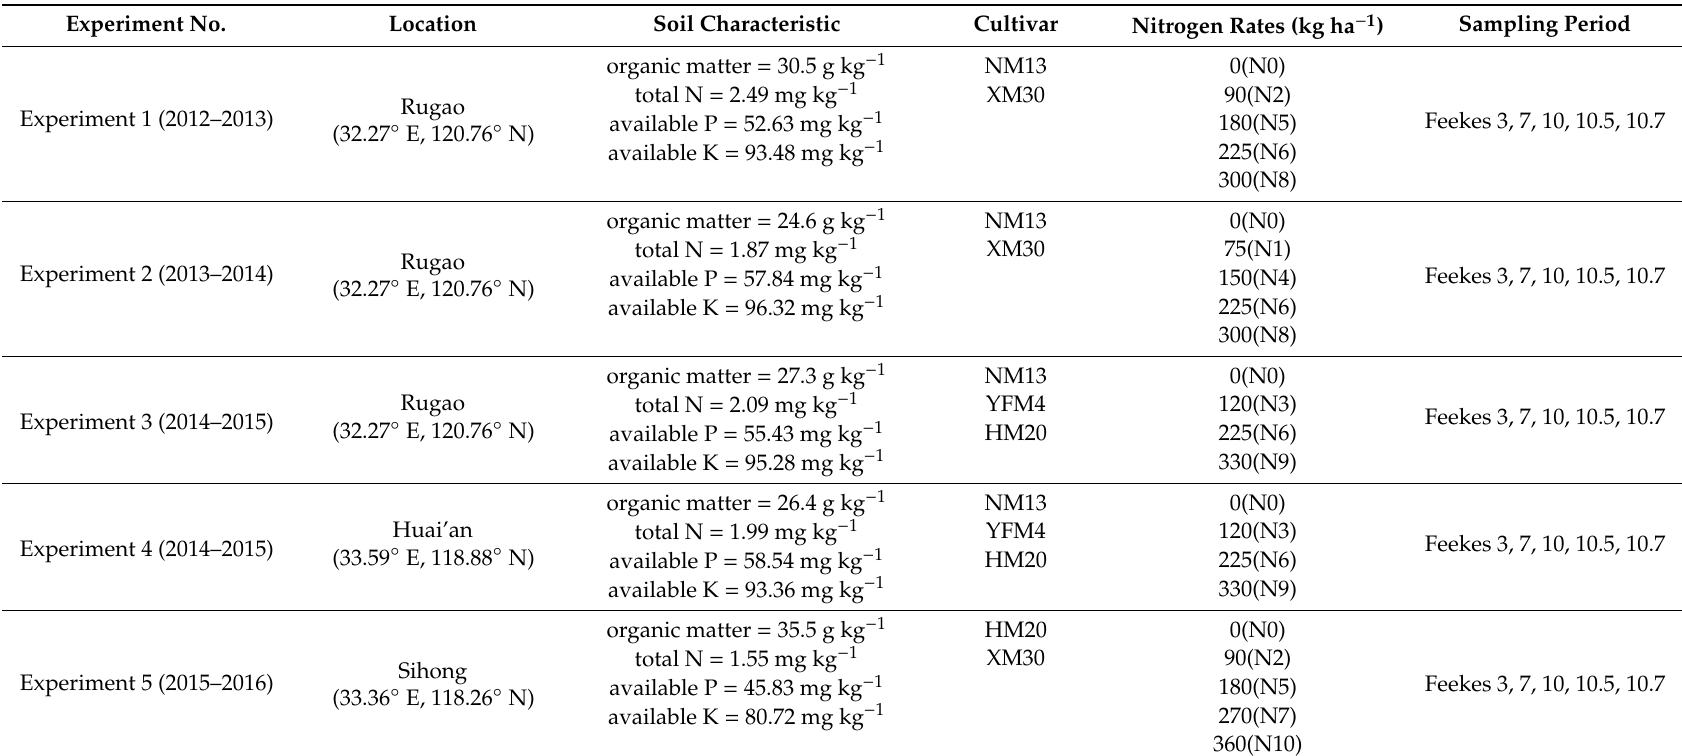
Table 1. Basic information about five field experiments conducted in Jiangsu province. Experiment